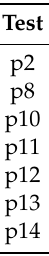
Table 1. Adjusted parameters for tests p2, p8, p10–p14 of the NIST test.